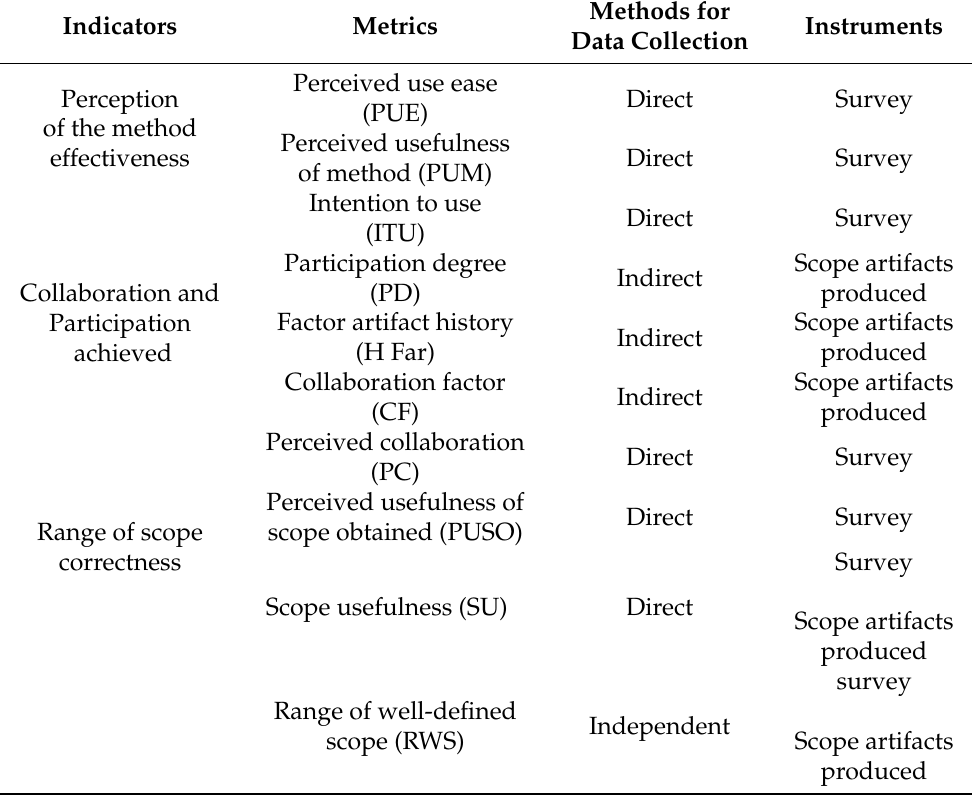
Table 4. Parameters of the